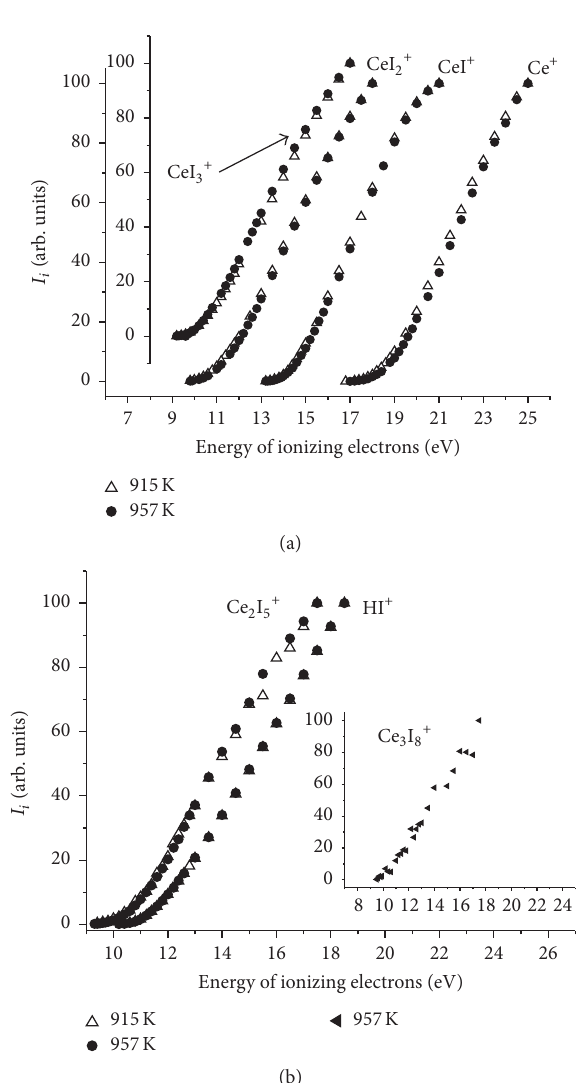
Figure 3: Ionization efficiency curves.